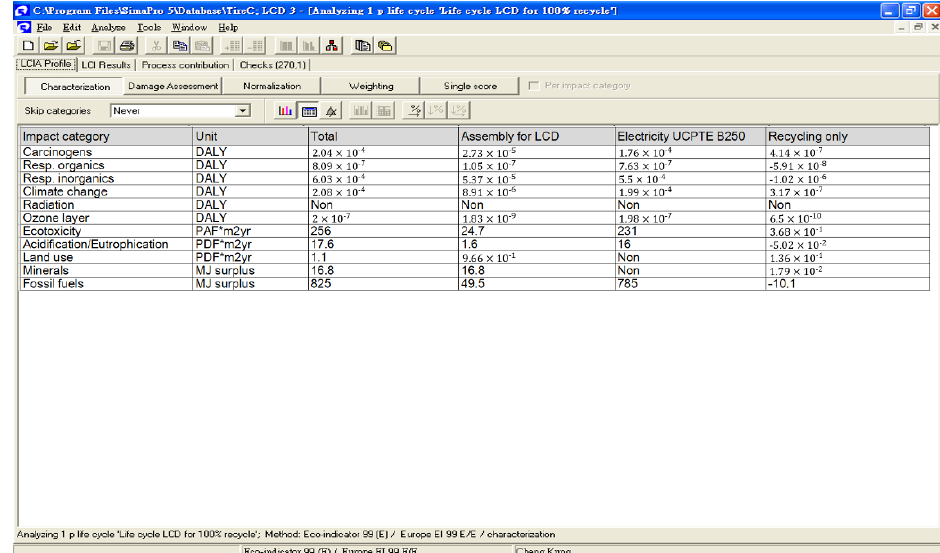
Figure 2. Environmental impact analysis of an LCD frame.